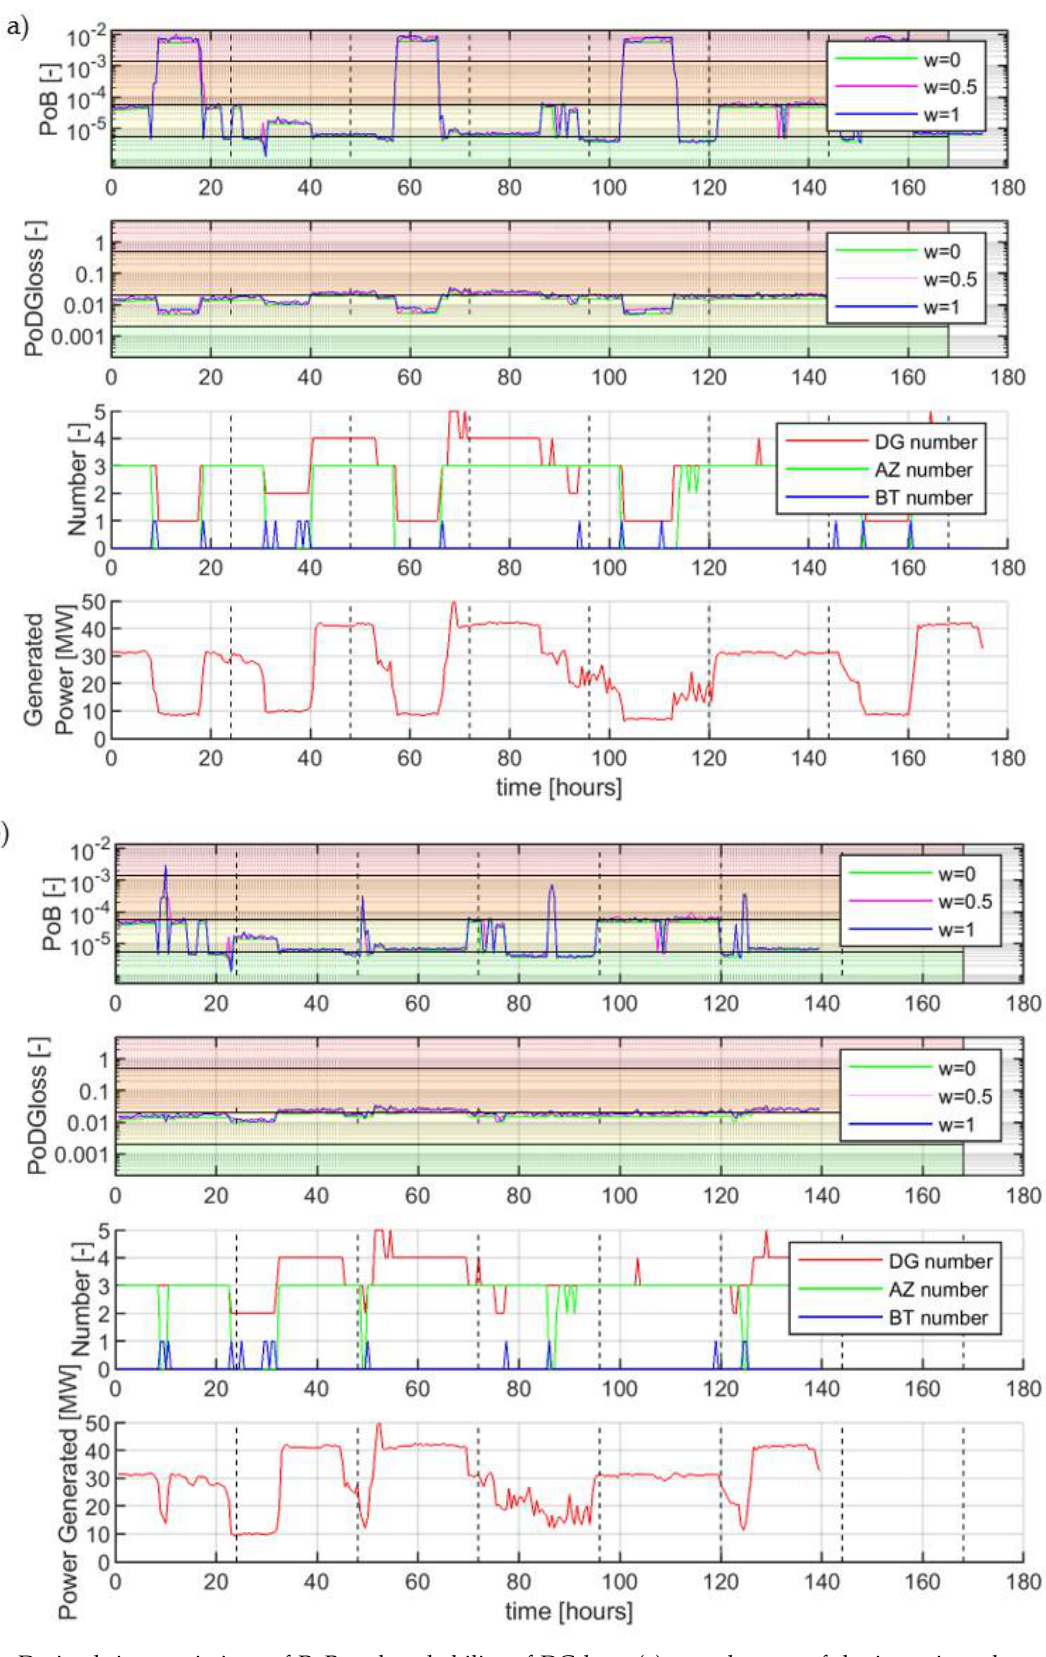
Figure 4. Derived time variations of PoB and probability of DG loss; ( a ) complete set of the investigated conditions; ( b ) Filtered set of operating conditions excluding the time periods where one DG set operate.